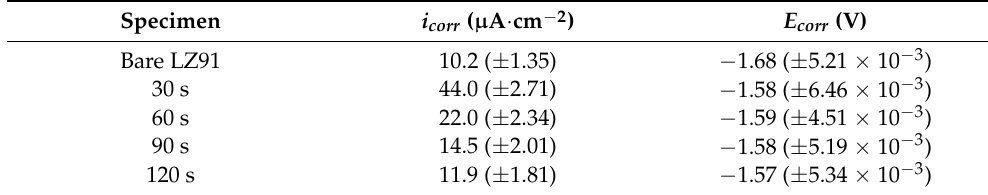
Table 1. Results for potentiodynamic polarization tests for bare LZ91 and the samples that undergo acid pickling pretreatment in 3.5 wt.% NaCl solution for different times.